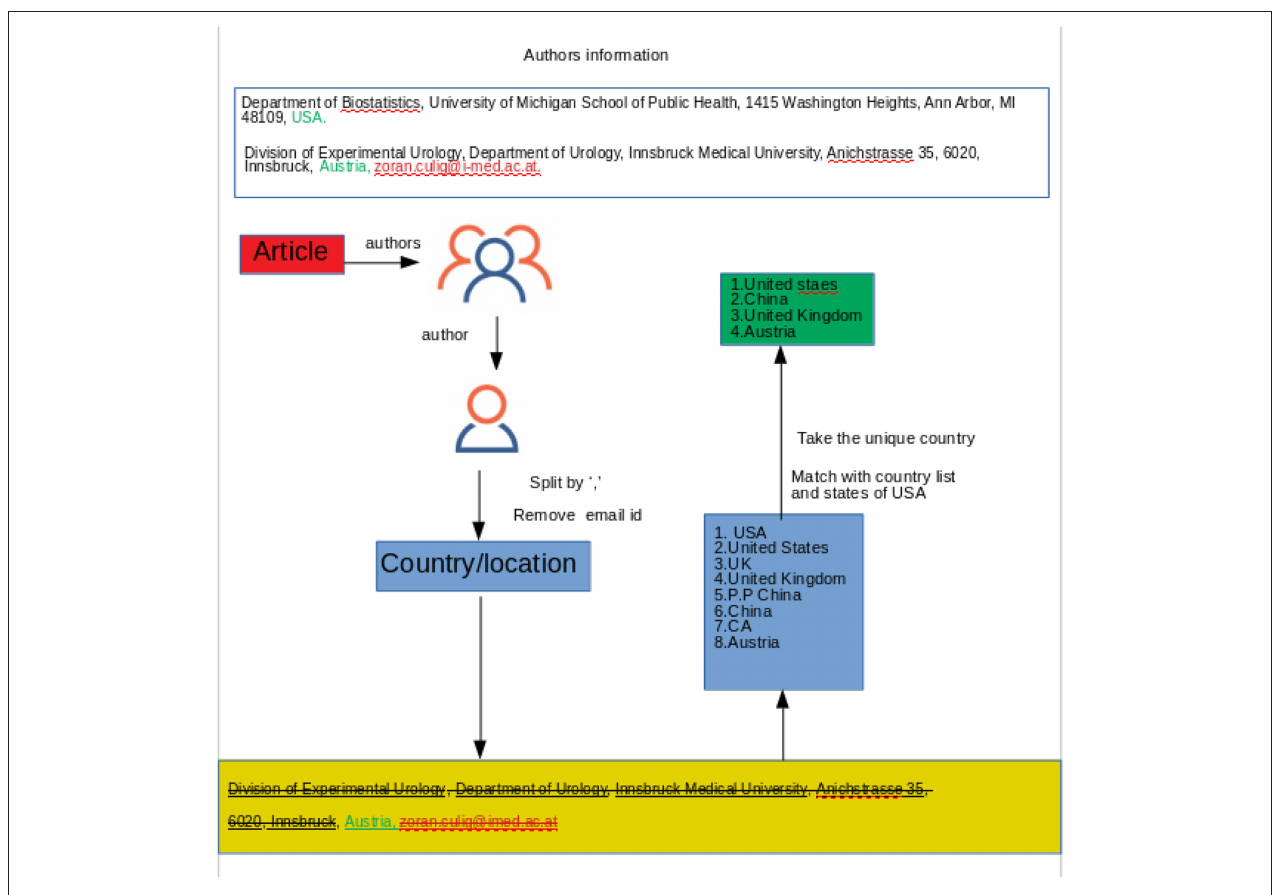
FIGURE 2 | Shown is the process how to identify the country associated with an